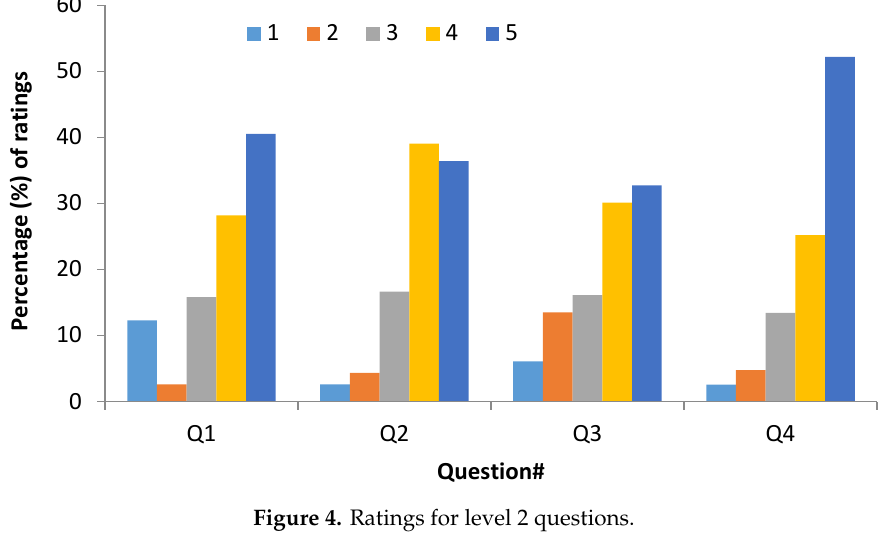
Figure 4. Ratings for level 2 questions.